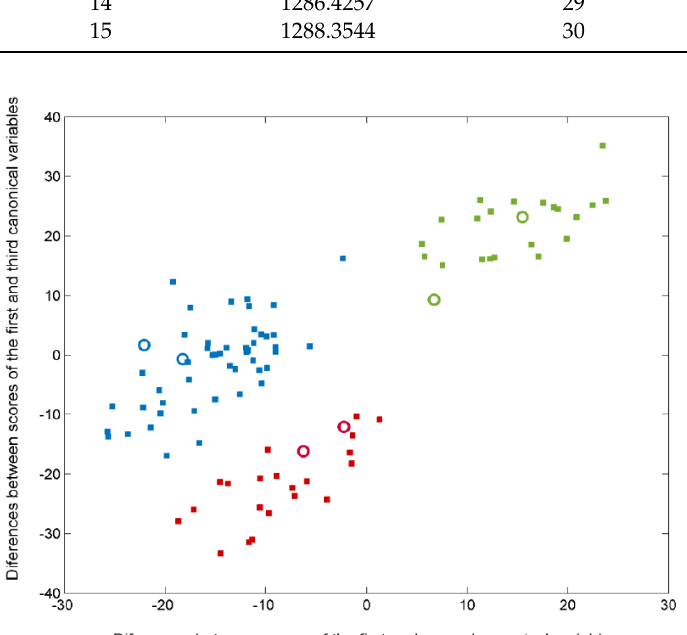
Figure 3. Plot of the differences between discriminant scores for plasma samples after performing SELECT-LDA in the global classification approach. The 3 categories considered are labelled as healthy control ( ), PD ( ), and AD ( ) subjects. Test samples are displayed as unfilled circles ( ).